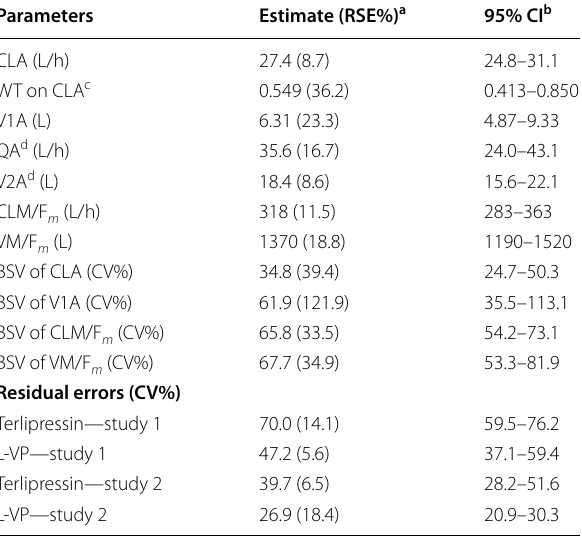
Table 2 Population pharmacokinetic parameters of